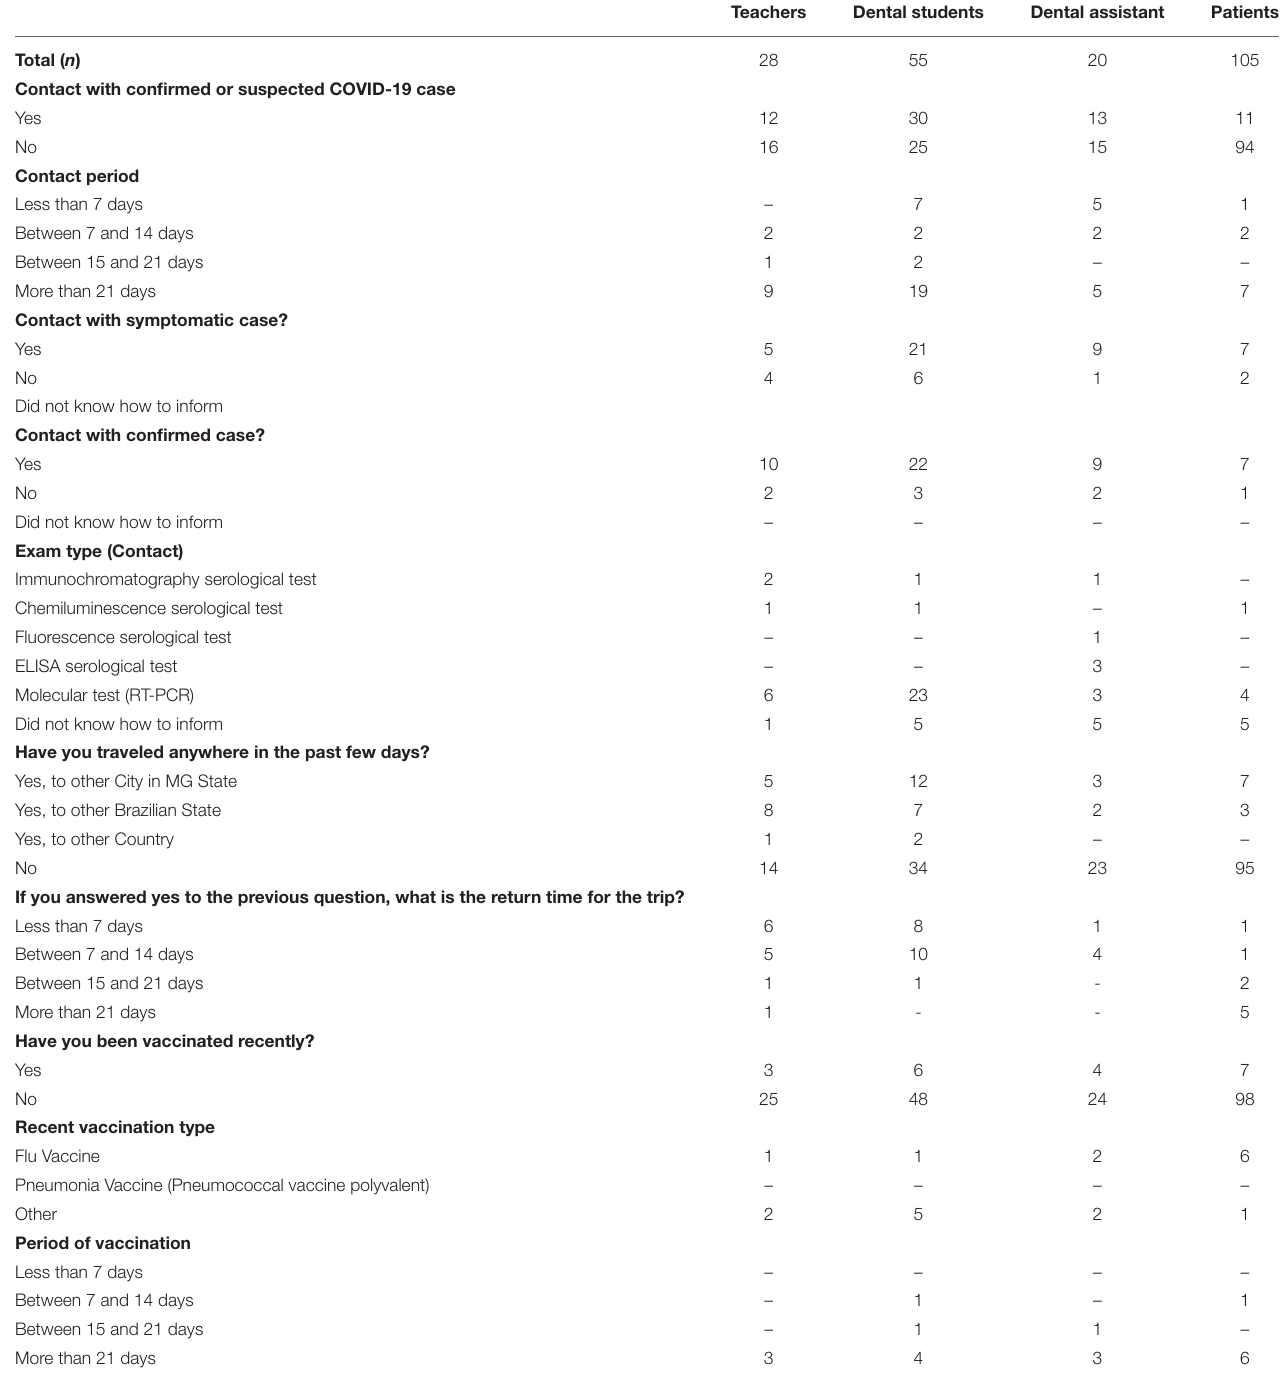
TABLE 2 | History of travel and previous contact with a COVID-19 positive